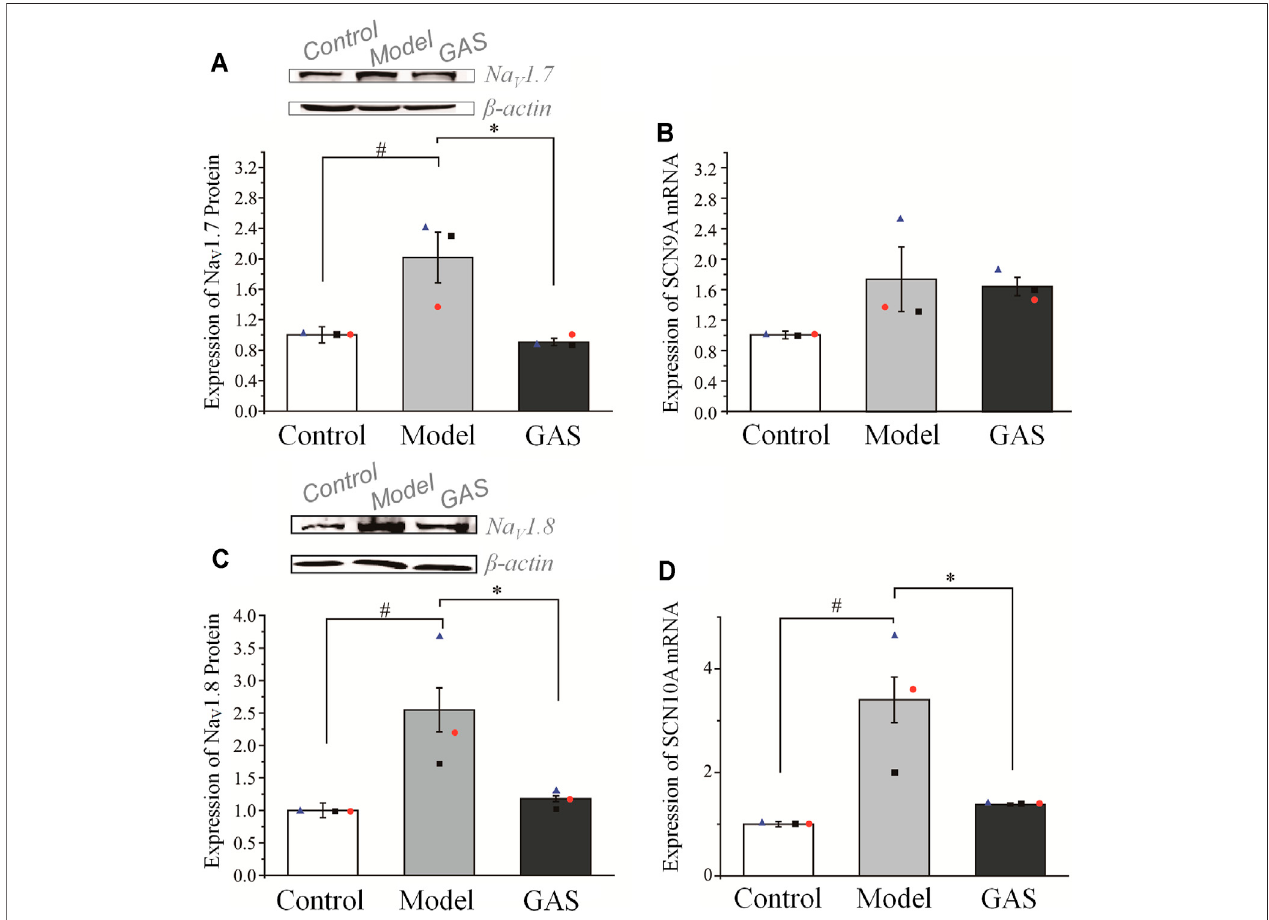
FIGURE 5 | Effects of GAS on the expression level of SCN9A and SCN10A genes and corresponding proteins: (A) down-regulation of Na V 1.7 channel proteins in DRG neurons of vincristine model by GAS ( n (cid:1) 3); (B) effects of GAS on the expression of SCN9A mRNA in DRG neurons in vincristine model; (C) the effects of GAS on the expression of Na V 1.8 channel protein in DRG neurons ( n (cid:1) 3); (D) in fl uences of GAS on the expression of SCN10A mRNA in DRG neurons of vincristine model (# p < 0.05, compared to the control group; *p < 0.05, compared to the model group; ANVOA- Bonferroni Test).